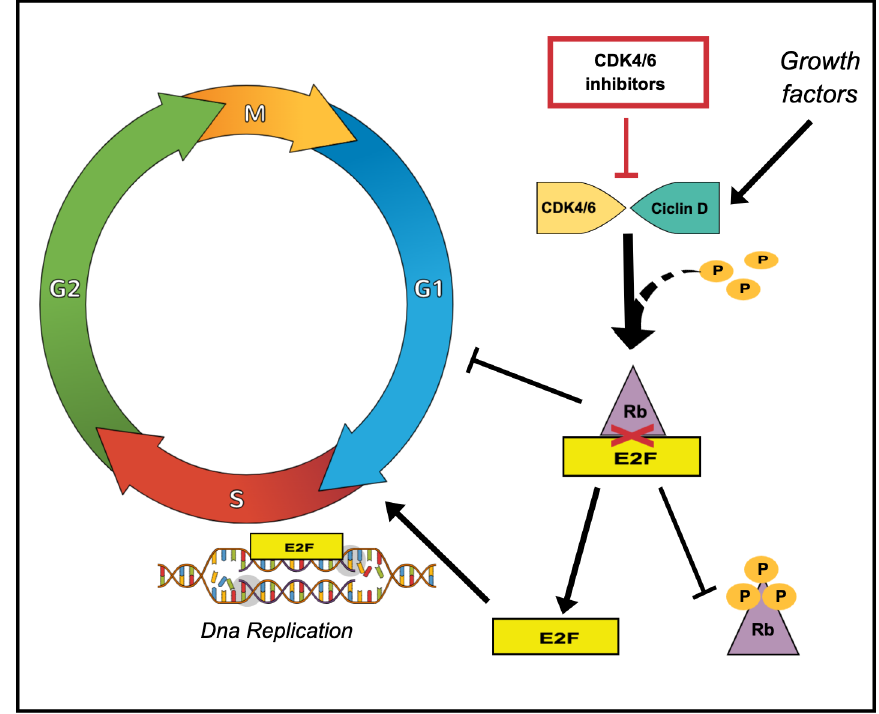
Figure 1. Main mechanism of action of CDK4/6 inhibitors on cell cycle progression . During early G1 phase, retinoblastoma-associated protein (Rb) is hypophosphorylated, thereby inhibiting the transcription factor E2F and preventing the initiation of DNA replication. Mitogenic signals lead to the expression of cyclin D and subsequent activation of cyclin D-CDK4/6 complexes, which suppresses Rb through phosphorylation and allows E2F to induce G1-S1 transition. CDK4/6 inhibitors halt the cell cycle arrest by inhibiting the activation of the cyclin D-CDK4/6 complexes and all downstream signalling pathways.